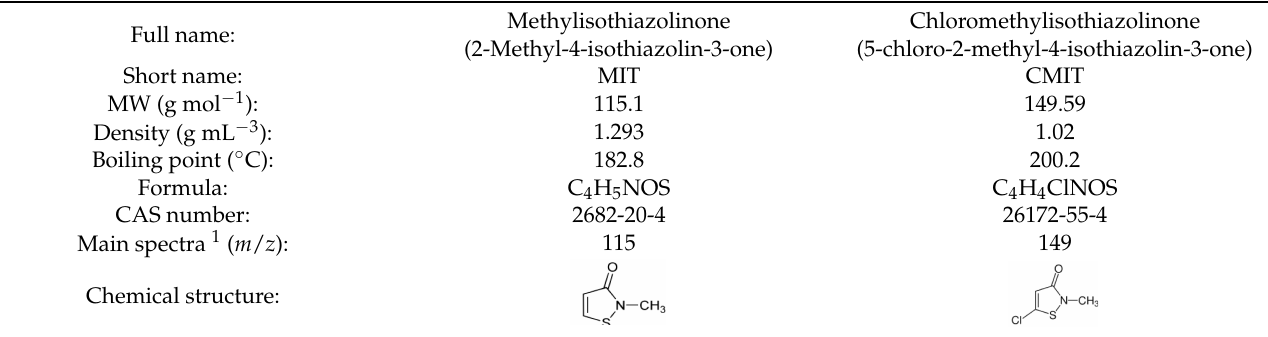
Table 1. Basic information of target compounds in this study.